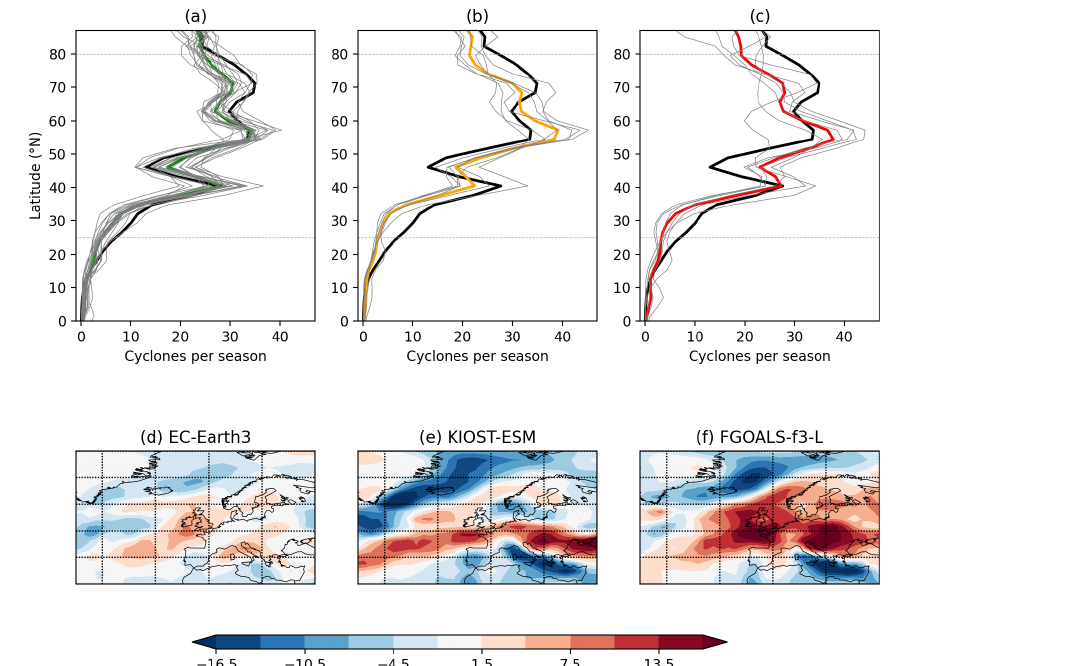
Figure 4. Examples of DJF storm track classifications; (a) , (b) and (c) show the RMSEs of the zonal mean track (20 ◦ W–20 ◦ E) for individual models and the classification mean for satisfactory (a) , unsatisfactory (b) and inadequate (c) . In (a) – (c) , grey lines are the individual models, solid-coloured lines are the group average, and the solid black line is ERA5. Individual examples are shown in the lower panel for track density bias for satisfactory (d) , unsatisfactory (e) and inadequate (f) models. Units of (d) – (f) are cyclones per season per 5 ◦ spherical